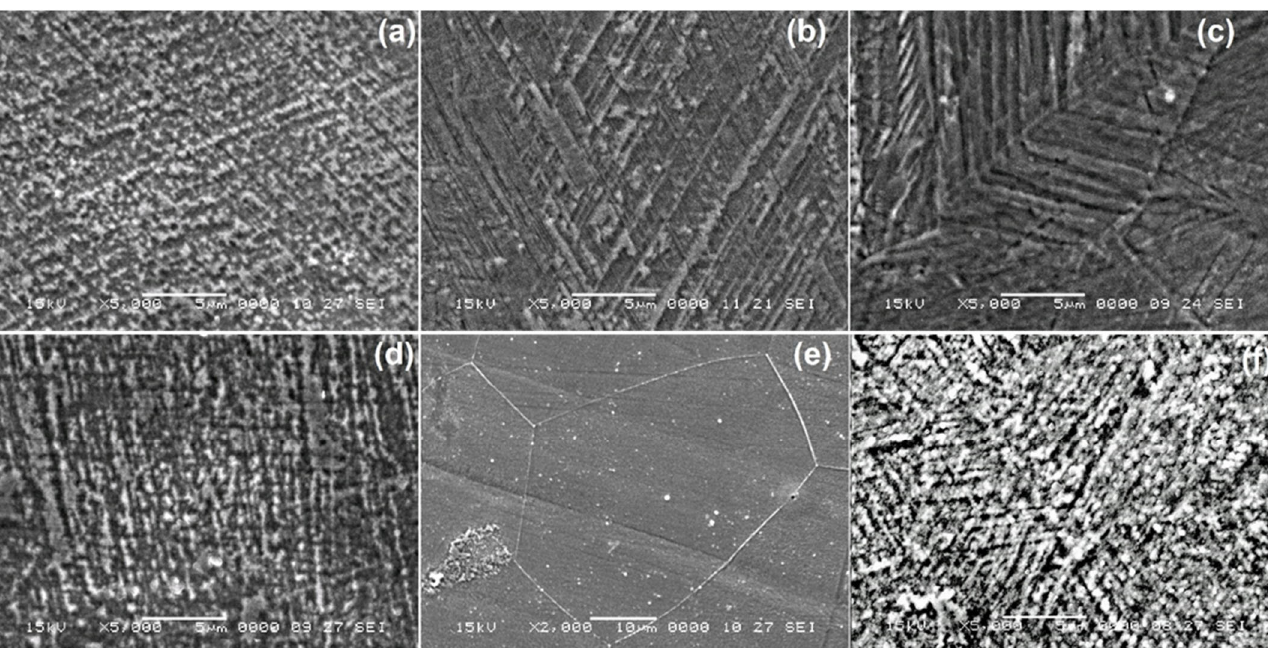
Figure 3. Typical SEM micrographs before DMA-SS-3PB: ( a ) in its initial hot-rolled state and at the specimens solution treated for: ( b ) 2 h; ( c ) 4 h; ( d ) 6 h; ( e ) 8 h; and ( f ) 10 h.